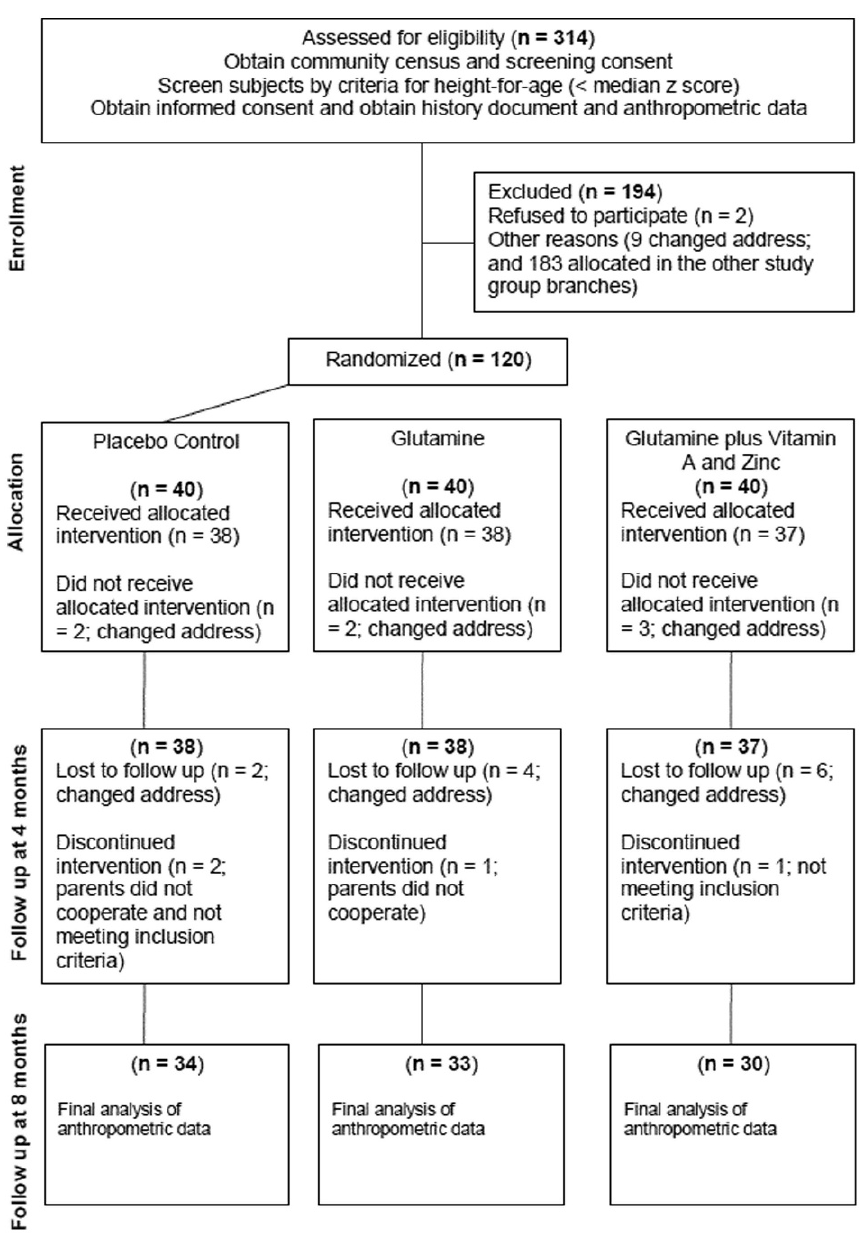
Figure 1 - Flow of micronutrient supplementation and biochemistry blood testing to study growth, intestinal barrier function, stress and satiety related hormones in Brazilian shantytown children from Fortaleza, northeastern, Brazil, during June 2000 - August 2004, with follow-up between June 2000 and